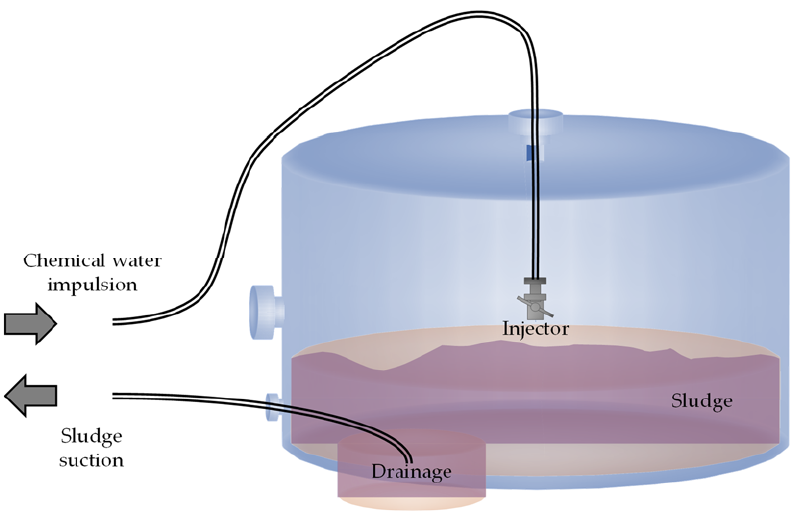
Figure 2. Chemical cleaning